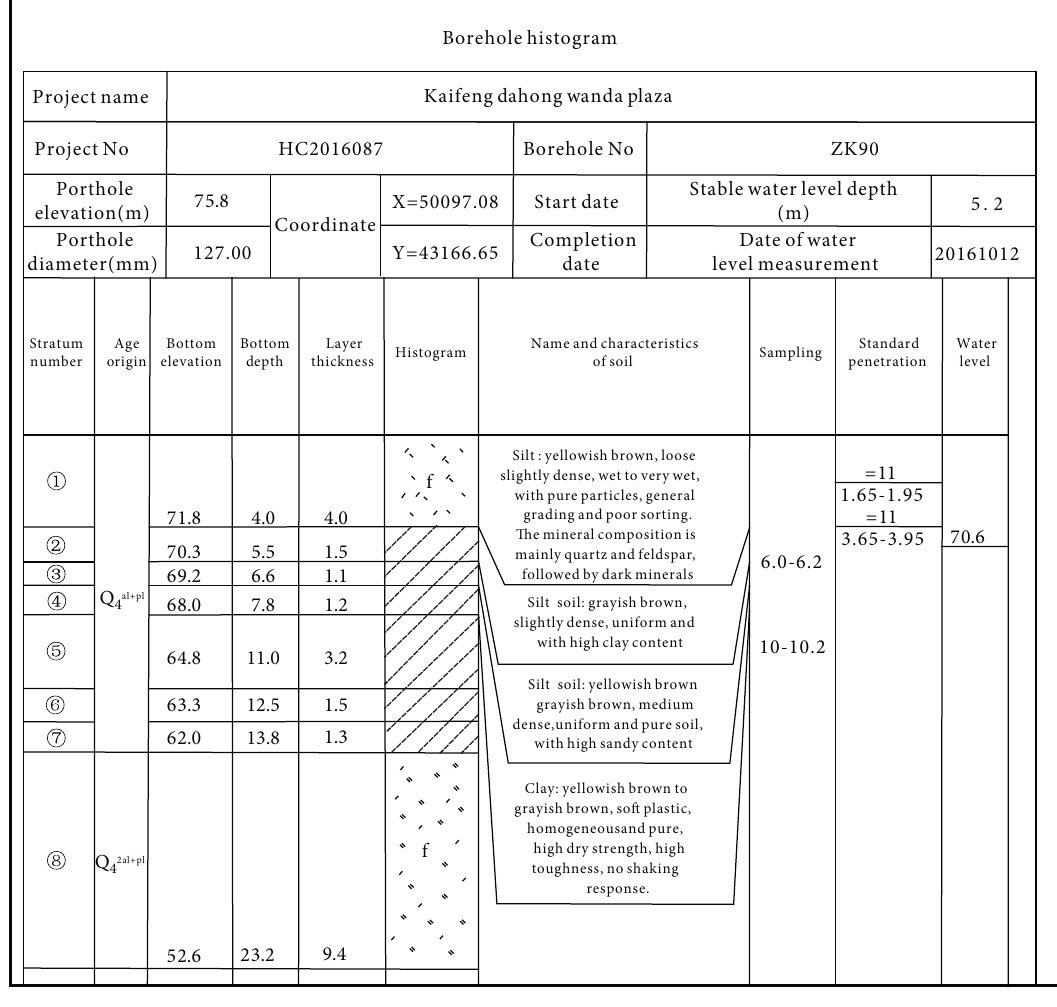
Figure 5: An original borehole log in Kaifeng City. Table 2: Extract information from an original borehole